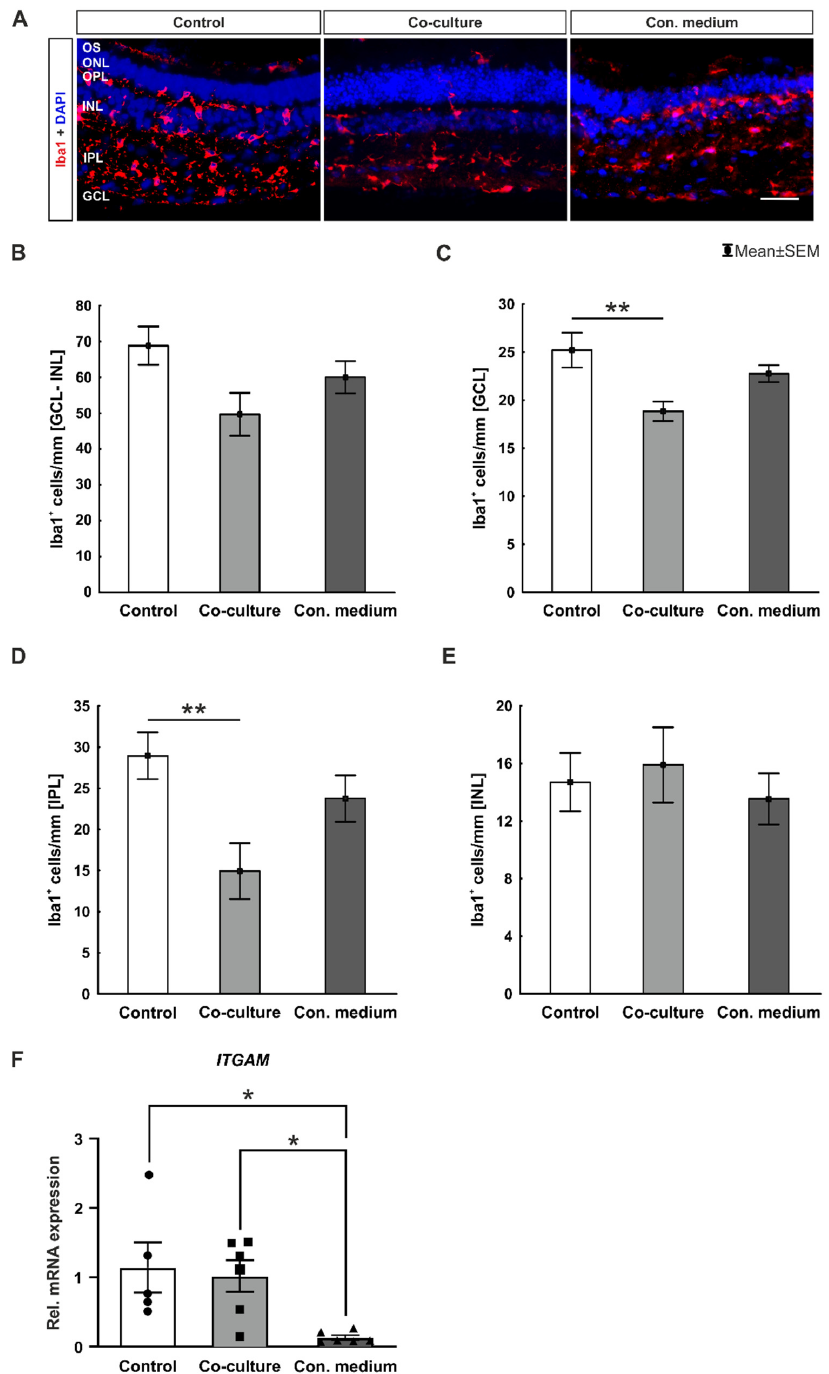
Figure 5. Co-cultivation with ppRPE led to reduced microglial activity in the neuroretina. ( A ) Iba1 antibody was used to label microglia (red). Cell nuclei were labeled with DAPI (blue). ( B ) The number of Iba1 + cells in the GCL to INL were similar in all three groups. ( C ) The number of Iba1 + cells in the GCL was reduced in the co-culture group compared to controls ( p = 0.005). ( D ) Analysis of the IPL revealed significantly lower Iba1 + cell counts in co-culture group than in controls ( p = 0.008). ( E ) The number of Iba1 + cells in the INL was comparable in all groups. ( F ) Relative mRNA expression of ITGAM was significantly decreased in the conditioned medium group compared co-culture ( p = 0.022) and control samples ( p = 0.023). OS, photoreceptor outer segments; ONL, outer nuclear layer; OPL, outer plexiform layer; INL, inner nuclear layer; IPL, inner plexiform layer; GCL, ganglion cell layer. Scale bar: 20 µ m, values are presented as mean ± SEM, ( A – E ) n = 8/group, ( F ) n = 6/group, * p < 0.05, ** p <